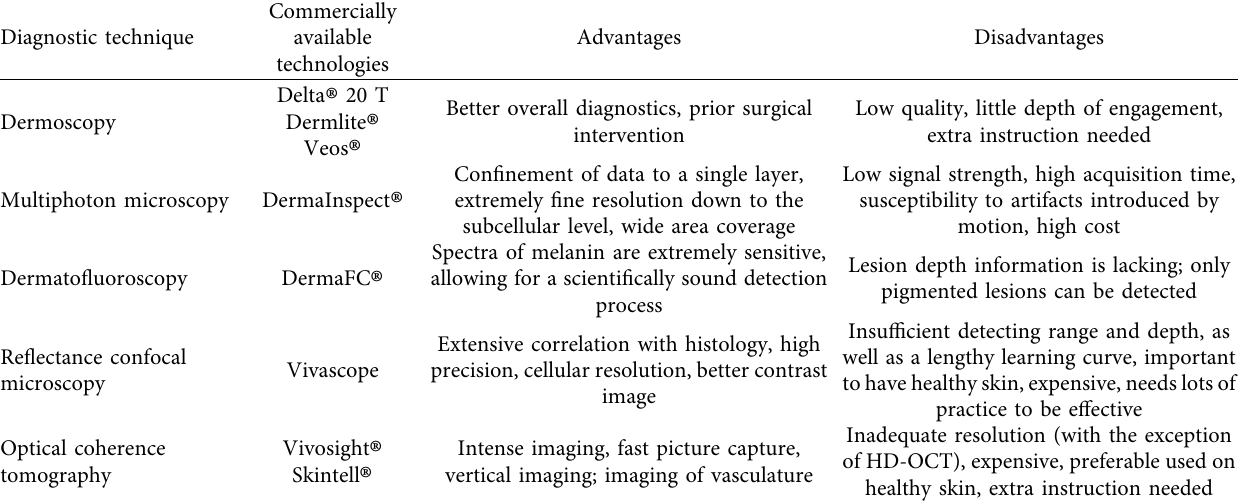
Table 1: Summary of optical techniques for skin cancer